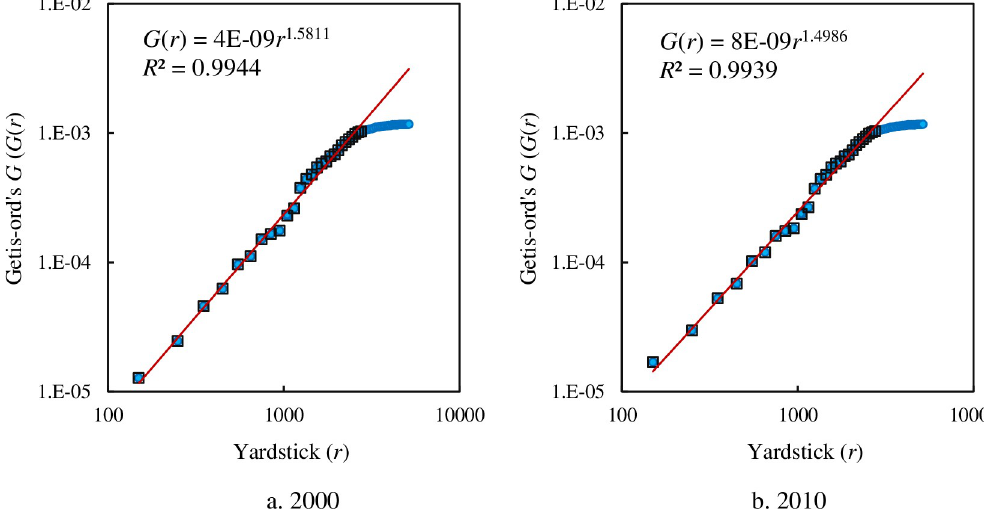
Fig 9. The scaling relations for the spatial autocorrelation function based on cumulative correlation and Getis-Ord’s index. Note: The solid dots represent all points of spatial autocorrelation functions, and the hollow blocks represent the points within the scaling range. The scaling range comes between 150 and 2750